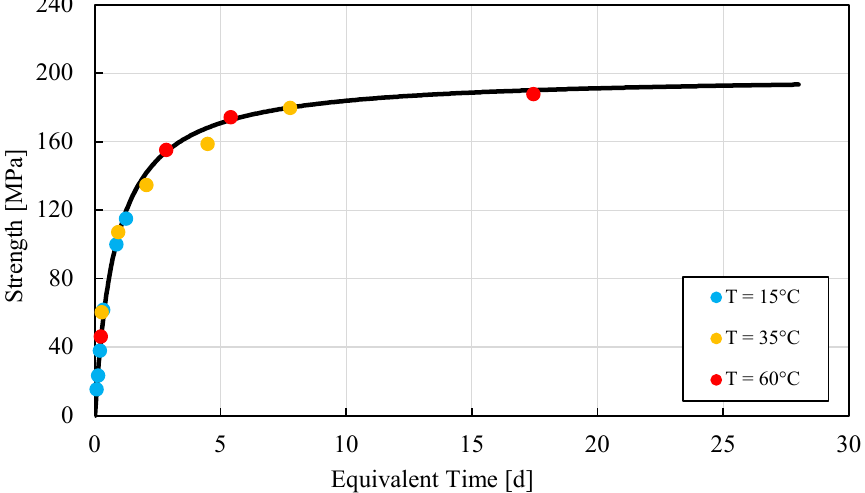
Figure 4. Strength−Equivalent Time curve for UHPC specimens. Each point corresponds to the mean value among 3 to 4 observations.